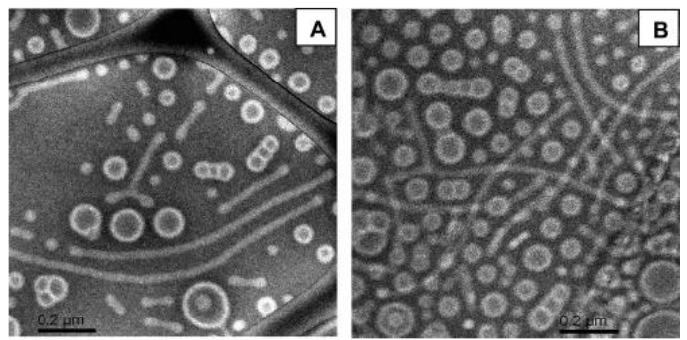
Figure 3. Cryo-TEM images of PB- b -PEO copolymer, with 0.25 mol % PEO, at a concentration of 1 wt % in [BMIM][PF6]. ( A ) Worm-like micelles with occasional Y-junctions and ( B ) micellar overlap. “Reprinted with permission from He, Y.; Li, Z.; Simone, P.; Lodge, T.P. Self-assembly of block copolymer micelles in an ionic liquid. J. Am. Chem. Soc. 2006 , 128 , 2745–2750. Copyright 2017 Americal